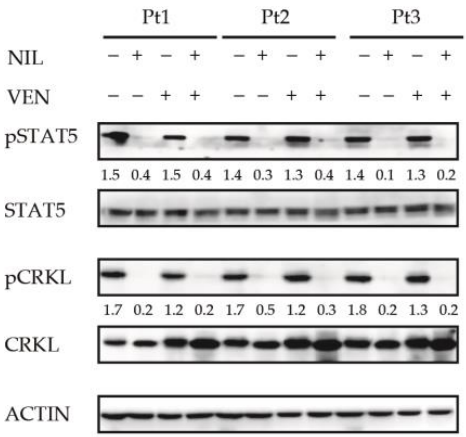
Figure 3. BCL2 and BCR-ABL1 co-targeting reduces the STAT5 and CRKL phosphorylation levels in committed CML CD34-positive cells. A Bone marrow CD34-positve progenitors (CML patients n = 3) were exposed to the indicated drugs (Venetoclax 400 nM, Nilotinib 2 µ M) and derived cell lysates separated by SDS-PAGE. Nitrocellulose membrane was hybridized with specified antibodies. Actin was used as loading control. The numbers indicate the densitometric analysis obtained using Image J software. VEN = Venetoclax, NIL = Nilotinib.